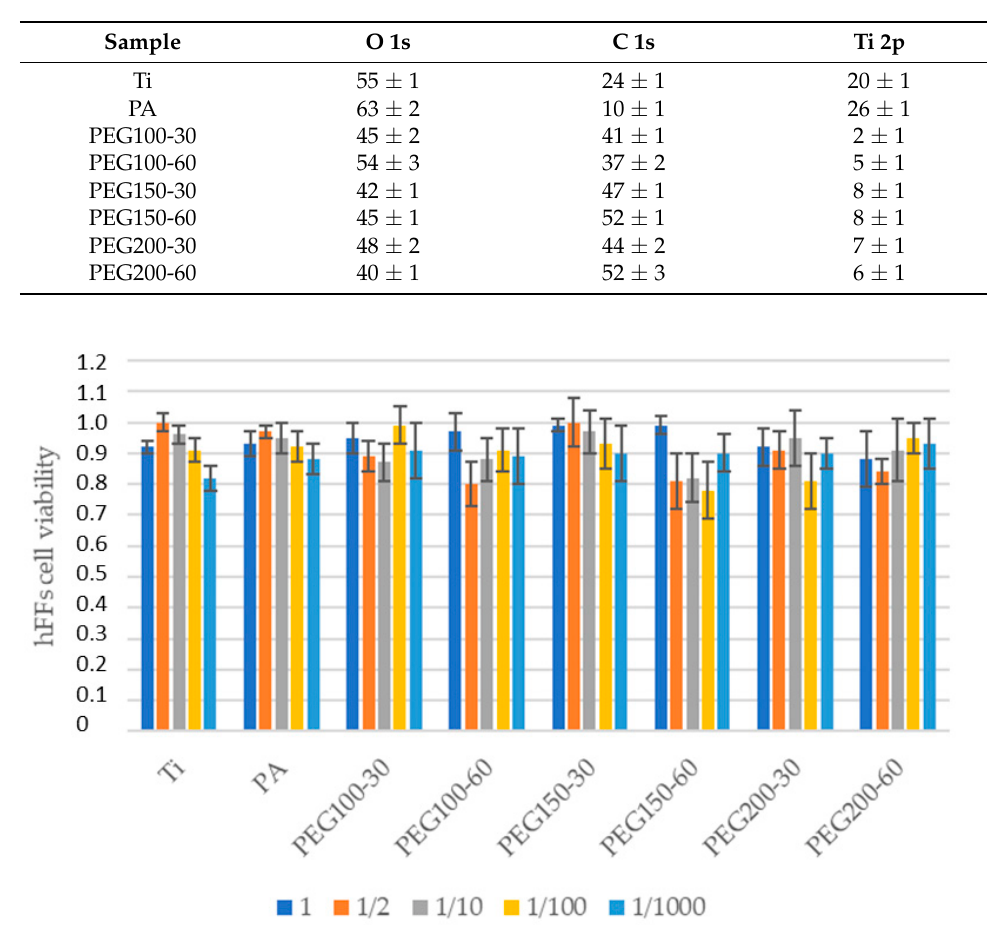
Figure 6. Cell viability of the hFFs for the different treatments and different dilutions.